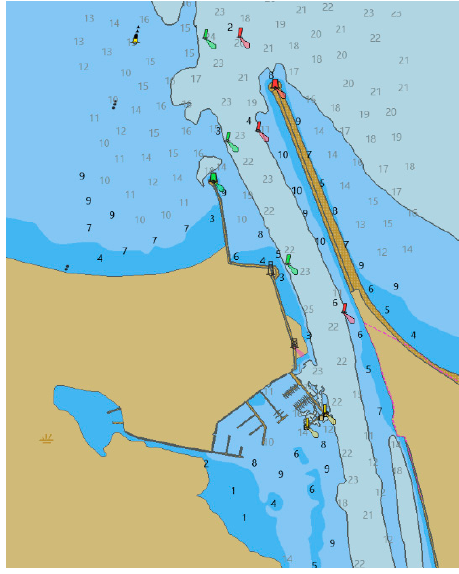
Figure 5. Navigation marks and depths on the approach fairway to the National Sailing Centre at the Gda ń sk University of Physical Education and Sport (NSC-GUPES).